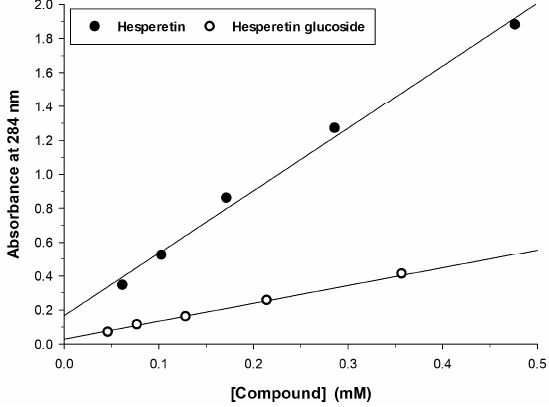
Figure 2. Absorbance at 284 nm vs. concentration for hesperetin and its monoglucoside.